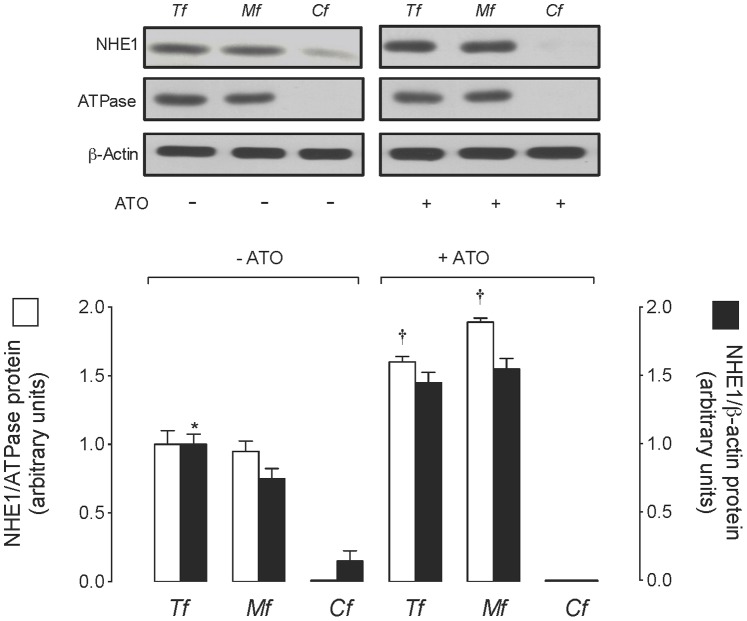
Effect of ATO on NHE1 protein abundance at the plasma membrane.Western blot for NHE1 and Na+, K+-ATPaseβ-subunit (ATPase, plasma membrane marker) in the total (Tf), plasma membrane (Mf) and cytoplasm (Cf) protein fractions from MDCK cells exposed for 48 hours to culture medium without (–) or with (+) 0.05 µmol/L arsenic trioxide (ATO) dissolved in water. ß-Actin was internal control. Lower panel: NHE1/ATPase (□) or NHE1/ß-actin (▪) ratio densitometries derived from data for NHE1/ATPase ratios normalized to 1 in cells in the absence of ATO. *P<0.05 versus all other corresponding values for NHE1/ß-actin ratios, †P<0.05 versus all other corresponding values for NHE1/ATPase ratios. Mean±S.E.M. (n = 6–10).